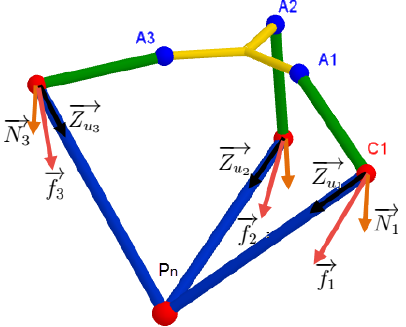
Figure 21. The forces applied on each elbow C i .